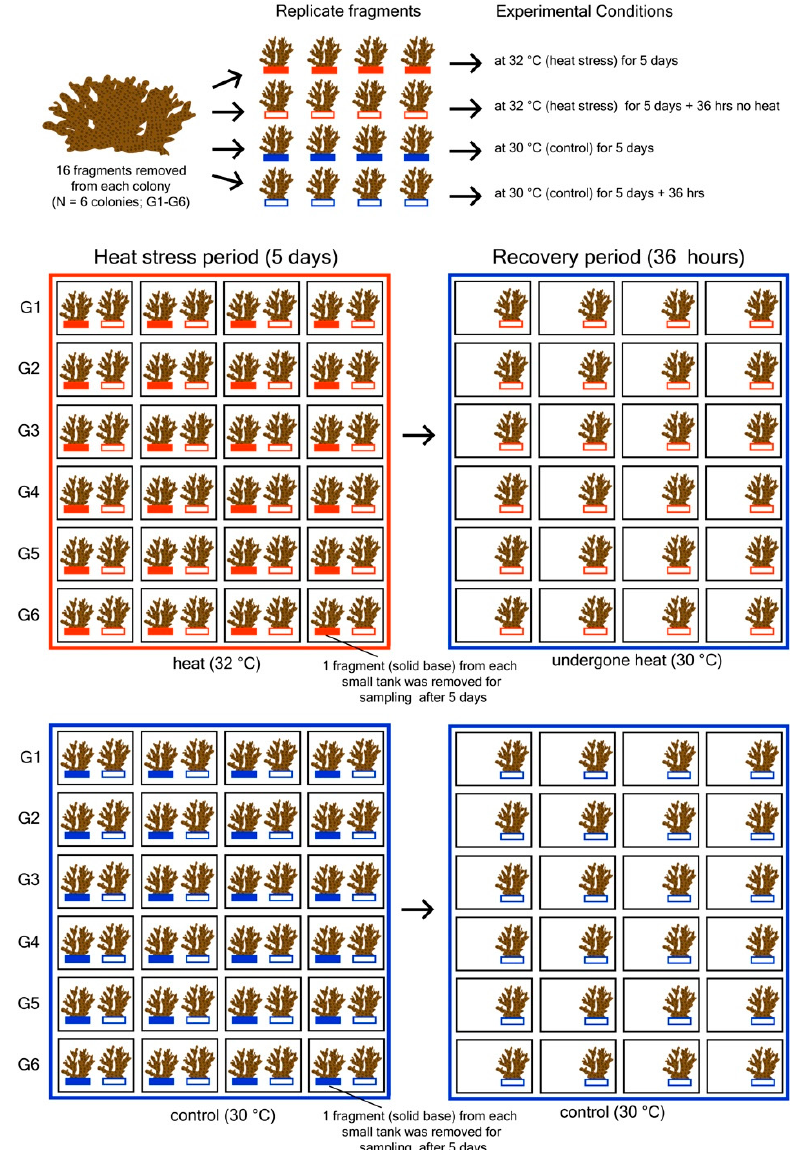
Figure 1. Experimental design showing each colony divided into fragments and assigned to two treatments (red fragment = heat, blue fragments = control) and periods (heat stress period, recovery period), totaling 96 fragments (two treatments × two periods × six colonies × four replicate fragments). A total of 24 small plastic tanks exposed to the heat treatment and 24 were controls; each contained two coral fragments from the same colony. Collection of 48 fragments (one from each small tank) was performed after 5 days for (destructive) analyses of endosymbiont density, chl a concentration, and gene expression levels. The remaining 48 fragments remained in their tanks, allowing the previously-heat stressed fragments to recover for 36 h at ambient temperature (30 °C). All 48 fragments were collected after the recovery period for analysis.